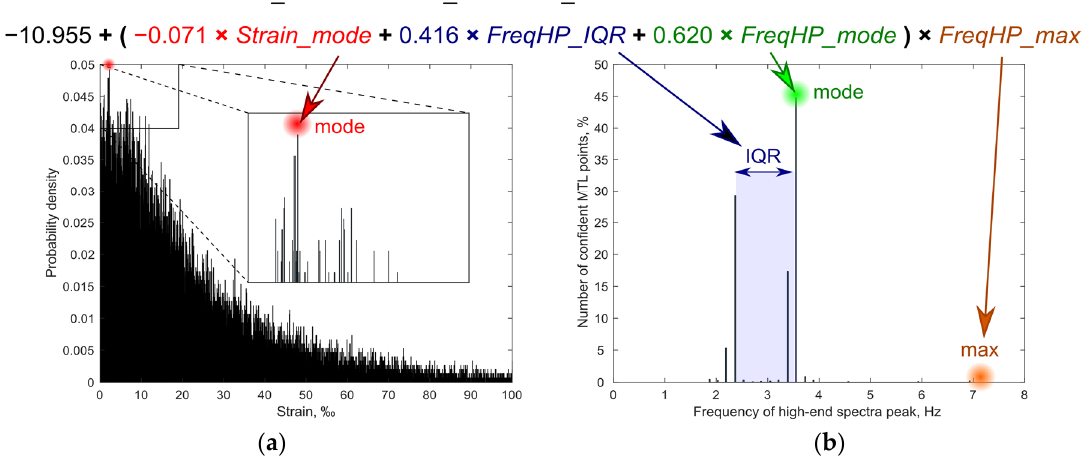
Figure 2. Visualization of four parameter estimates which were included into logistic regression models. Example based on the third model. Sub-images represent: ( a ) distribution of strain and ( b ) frequency of the high-end spectra peak (FreqHP) of confidently repeatable moving individual points, from medial temporal lobe (MTL). FreqHP_IQR—FreqHP interquartile range, Hz; FreqHP_max—FreqHP maximum, Hz; FreqHP_mode—FreqHP mode, Hz; Strain_mode—strain mode, ‰.